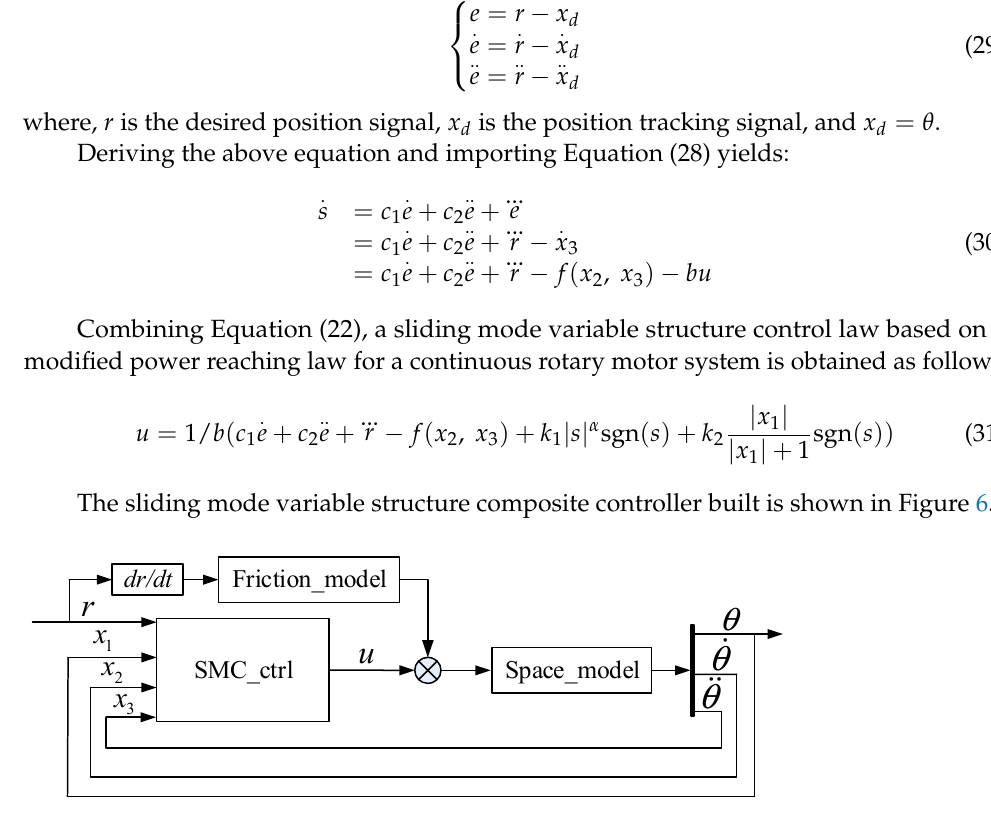
Figure 6. Sliding mode variable structure composite controller.